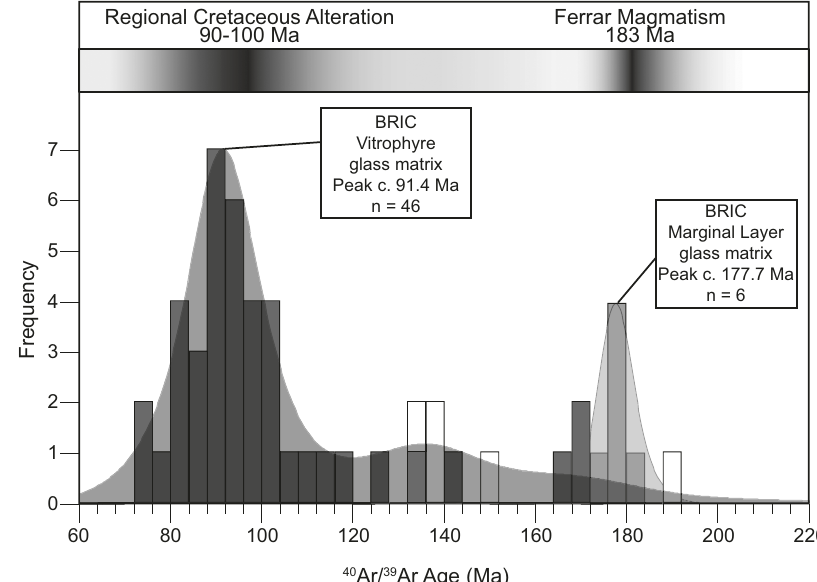
Fig. 5 | Ar/Ar geochronology data for Butcher Ridge Igneous Complex rocks. Kernel density plot and histogram of in situ 40 Ar/ 39 Ar geochronology data for vitrophyre pod samples (dark gray), the vitrophyre layer sample (white), and the